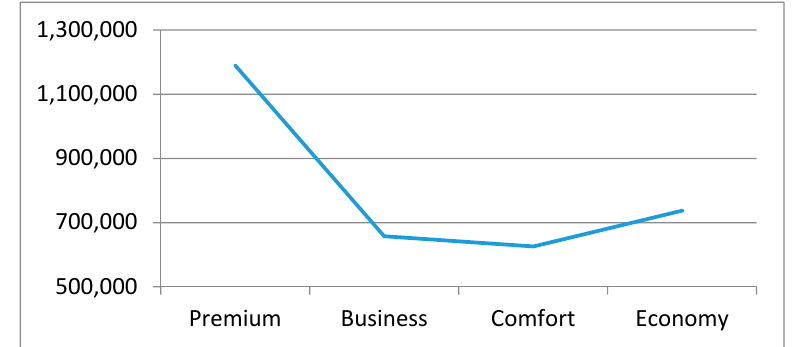
Figure 7. Impact total (kg CO 2 equivalent) vs. building comfort level.